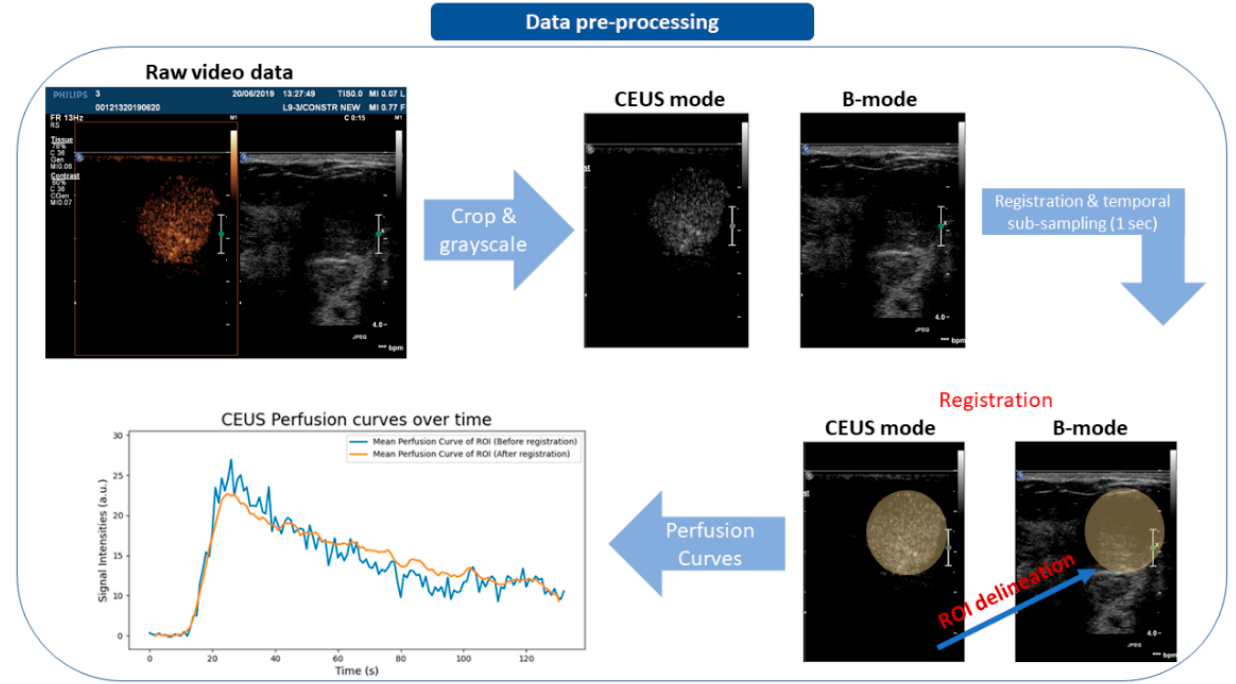
Figure 1. Data pre-processing workflow.